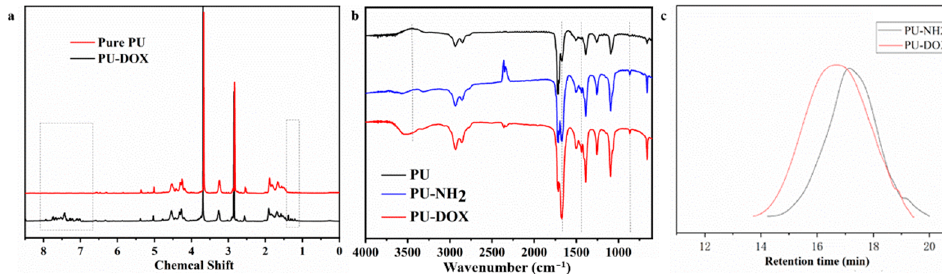
Figure 2. Structural characterization of polymers: ( a ) 1 H NMR spectra of pure PU and PU-hyd-DOX; ( b ) FT-IR spectra of pure PU, PU-NH 2 and PU-hyd-DOX; ( c ) The elution time of PU-NH 2 and PU-hyd-DOX.